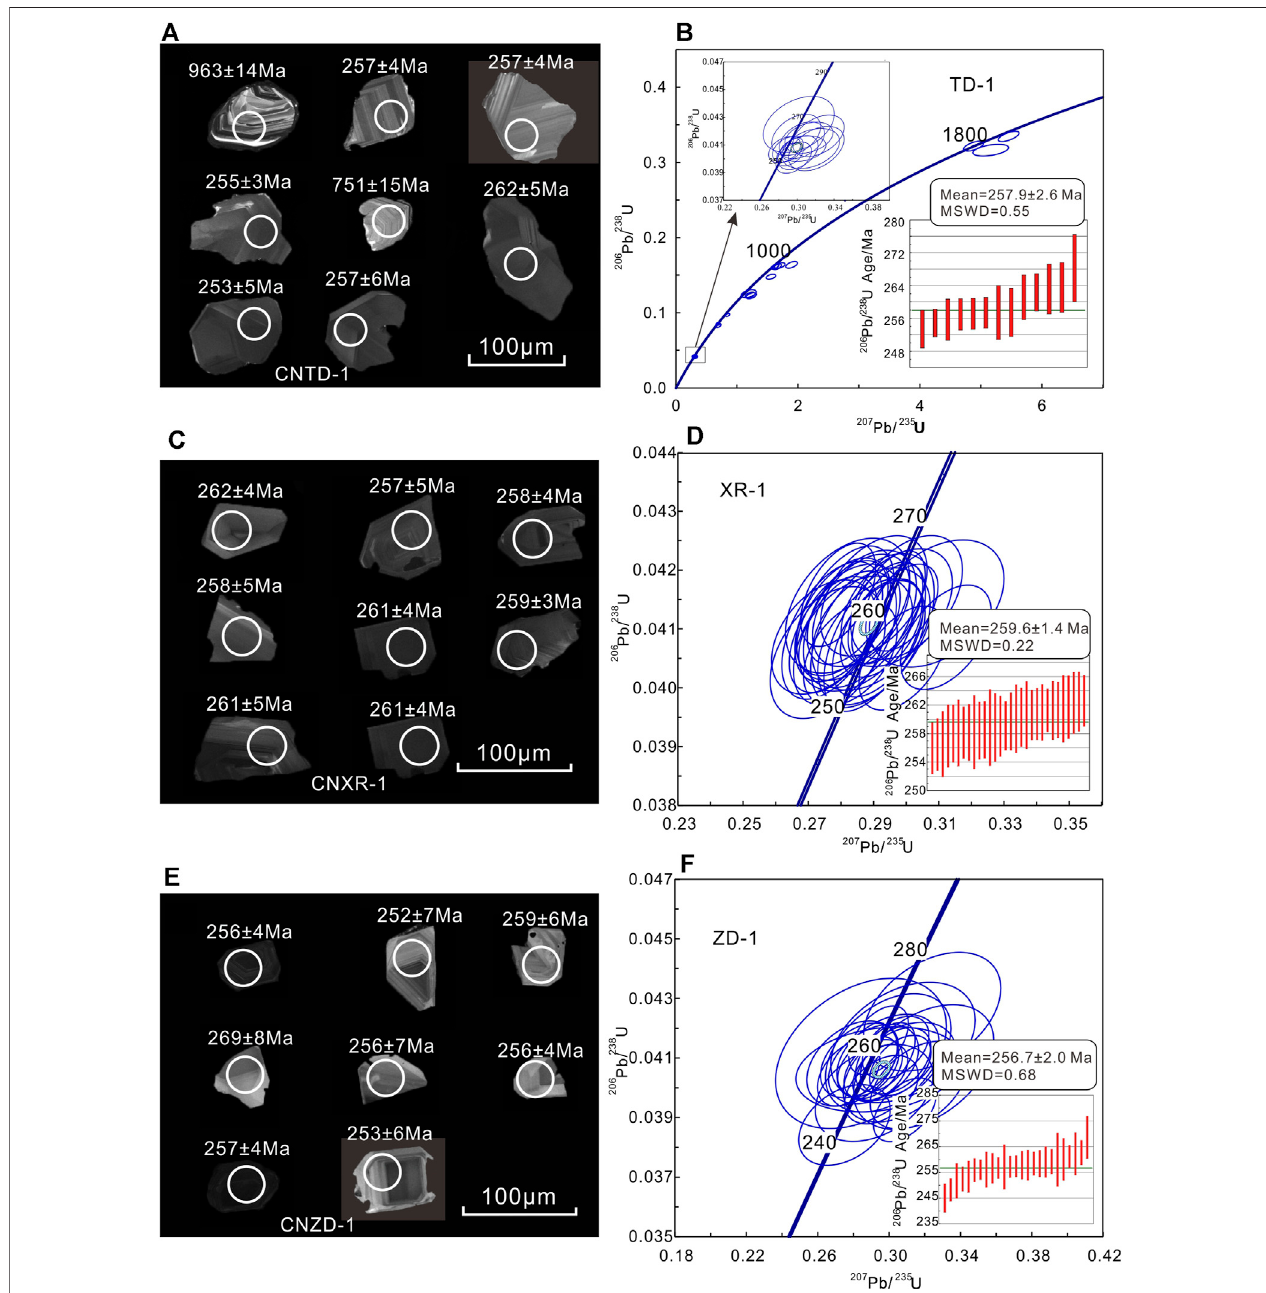
FIGURE7| Representativezircon CLimage andconcordia diagram fortheLonglinbasaltsamples.Thehollowringisthepositionofanalyticalspot. Numbersnear the analytical spots are the U-Pb ages (Ma). ( Table 3 ), 27 analysis spots yielded 176 Hf/ 177 Hf (cid:1)